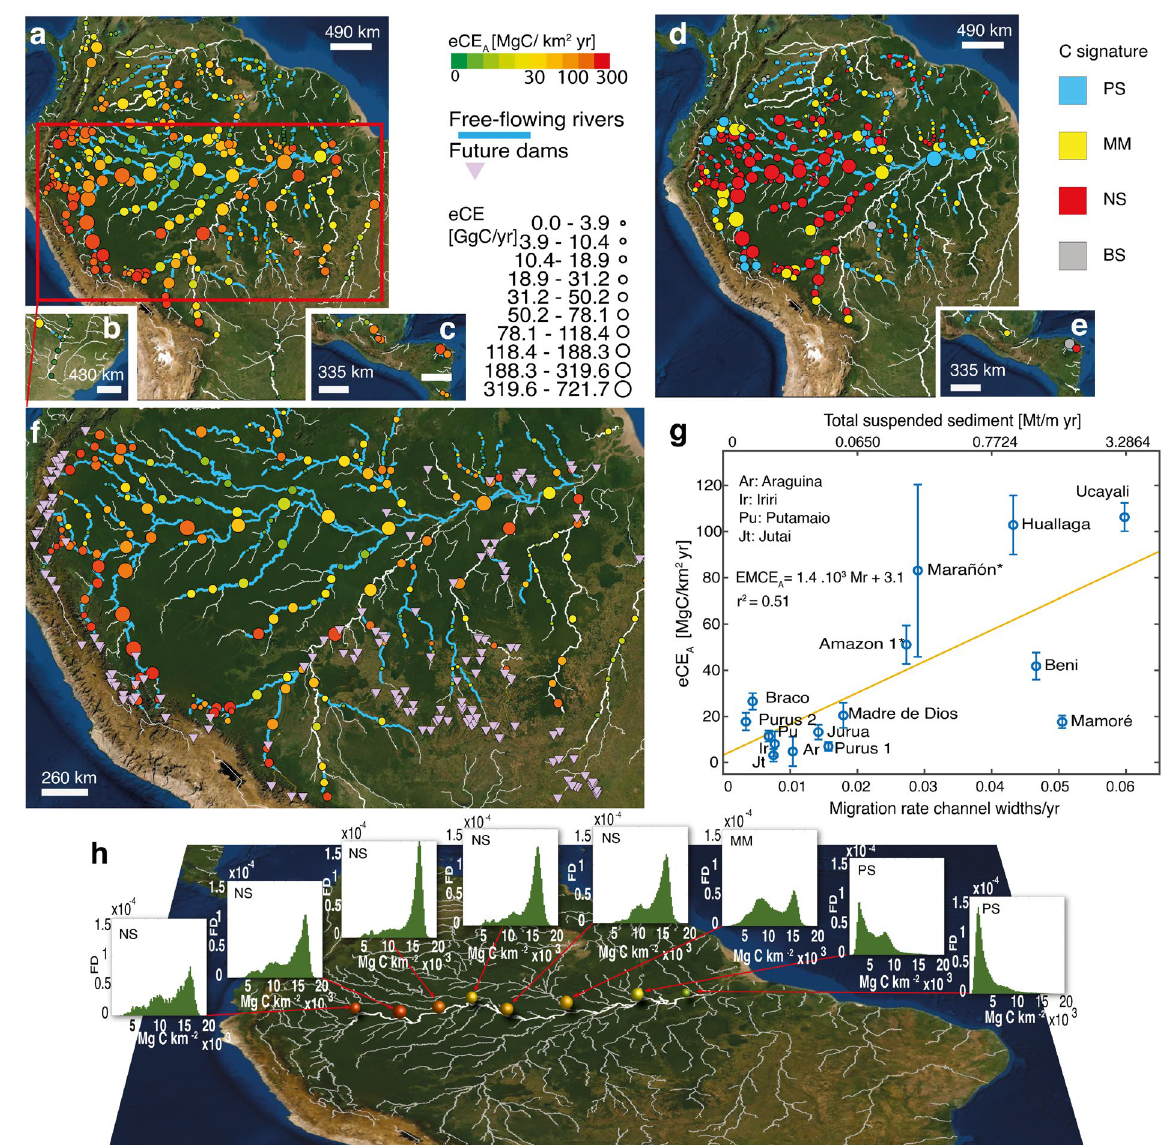
Figure 2. Eco-morphodynamic Carbon Export (eCE) and carbon signature of the largest rivers in Tropical America. The eCE in ( a ) South America, ( b ) Paraguay-South Brasil, ( c ) Central America. Carbon signature in ( d ) South America, ( e ) Central America. Point size is proportional to eCE, colors show eCEA ( a – c , f , h ) and signature ( d , e ). Blue reaches indicate free-flowing streams (CSI index > 95%, after Ref. 33 ). See Supplementary Discussion for details about the analysis of an additional group of rivers (defined as moderately altered by Ref. 33 , not considered in the main analysis). ( f ) Magnified view of Andean-foreland forest basin and distribution of planned new large hydroelectric dams (>1 MW, see Ref. 36 ) shown by pink triangles. ( l ) Correlation between sediment transport, migration rate, and carbon export (data on migration rate and sediment transport from ref. 25 , in the river marked with * the migration rate was derived from the relationship Mr = 0.043. TSS suggested by Ref. 25 , where TSS is the total suspended sediment. ( h ) The longitudinal sequence of signatures in the frequency distribution (FD) for Amazon River corridor biomass density (NS, negatively skewed; MM, multimodal; PS, positively Negro; (2) Intensive Exporters (eCEA > 90 MgC/ km 2 year) with less extensive fluvial corridors but high migra- tion rates (Mr > 4 × 10 − 2 channel widths per year, Ref. 25 ) such as the Ucayali River. As pointed out by Ref. 25 , the whitewater rivers in the Andean-foreland basin—Ucayali, Huallaga, Beni and Maranon—are highly dynamic due to the high suspended sediment load they carry (0.23 ± 0.16 Mt/year). In fact, the suspended load in these catchments was found to be positively correlated with river migration rates 37 because sediment transport increases the buildup of fluvial bars, which enhances the topographic steering of longitudinal flow 38 and thus promotes shear stress and bank erosion 39 . Such a key phenomenon, combined with the nutrient-rich sediment and high biomass density (8–16 GgC/ km 2 ) of fluvial corridors in the Andean-foreland